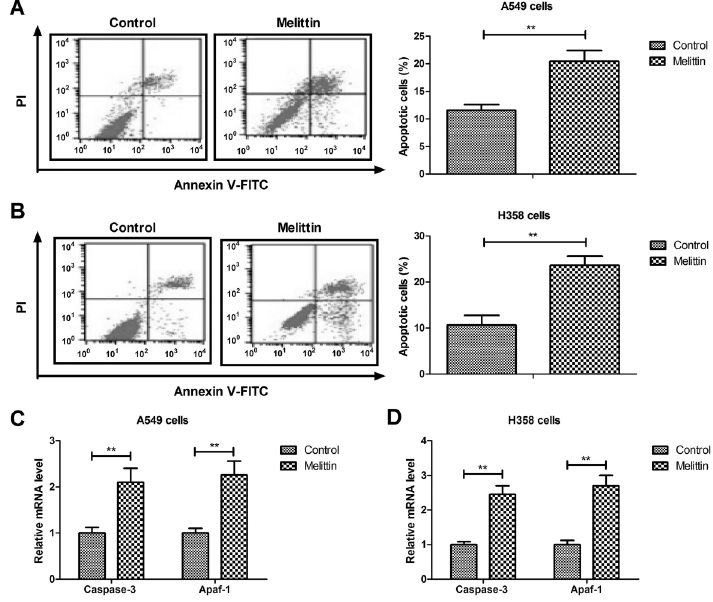
Figure 2. Melittin induced apoptosis of non-small-cell lung cancer cells (A549 and H358). A and B , Effects of melittin (2.0 m g/mL) on apoptosis. C and D , Effects of melittin on pro-apoptosis gene expression of caspase-3 and Apaf-1 . **P o 0.01 (Student ’ s t